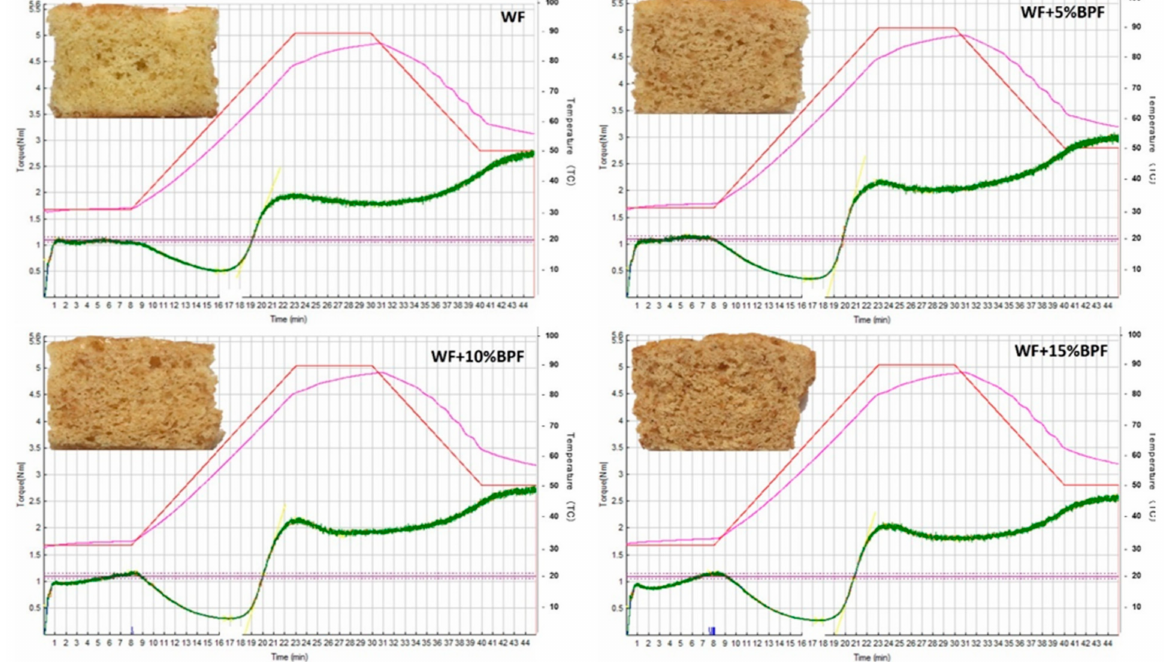
Figure 2. The thermo-mechanical and rheological properties of WF 72% and substituted WF with BPF ( A. digitate ) at different substitution levels, 5% (WF + 5% BPF), 10% (WF + 10% BPF), and 15% (WF + 15%